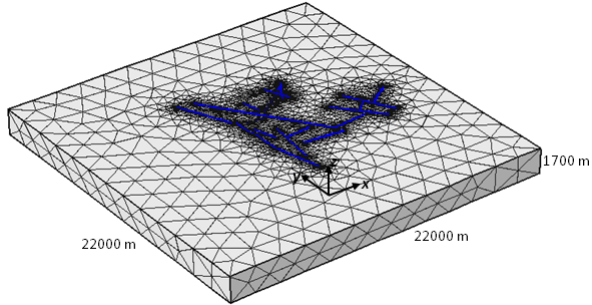
Figure 2. Finite element discretization of the rock mass with a sys- tem of interconnecting fracture zones. A discretization of 158728 tetrahedral elements is